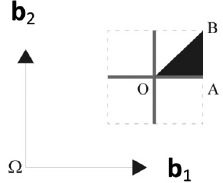
Figure 3. Irreducible part of the fi rst Brillouin